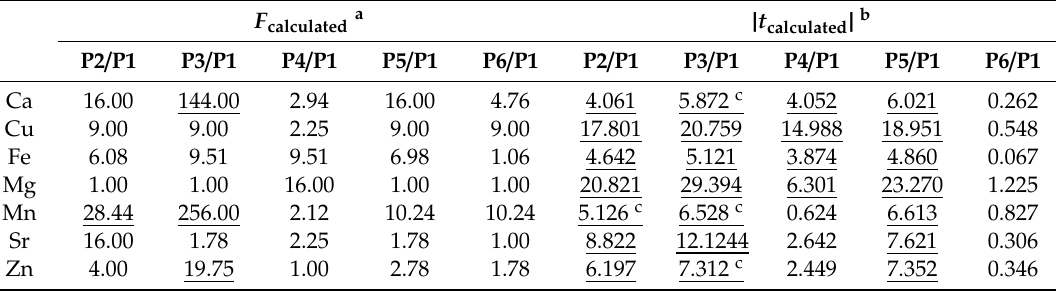
Table 3. Calculated values of the F -test ( F calculated ) and the t -test ( | t calculated | ) for comparison of standard deviations of mean concentrations of elements and these mean concentrations, respectively,